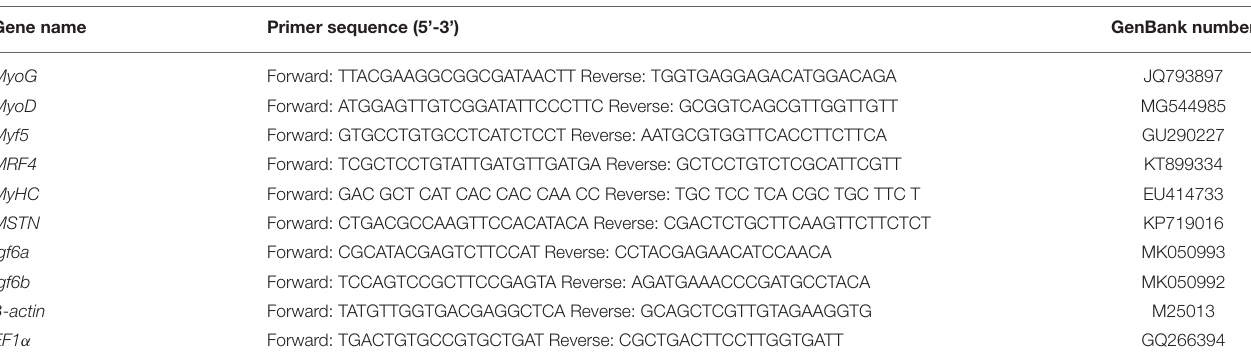
TABLE 2 | Primers used in real-time